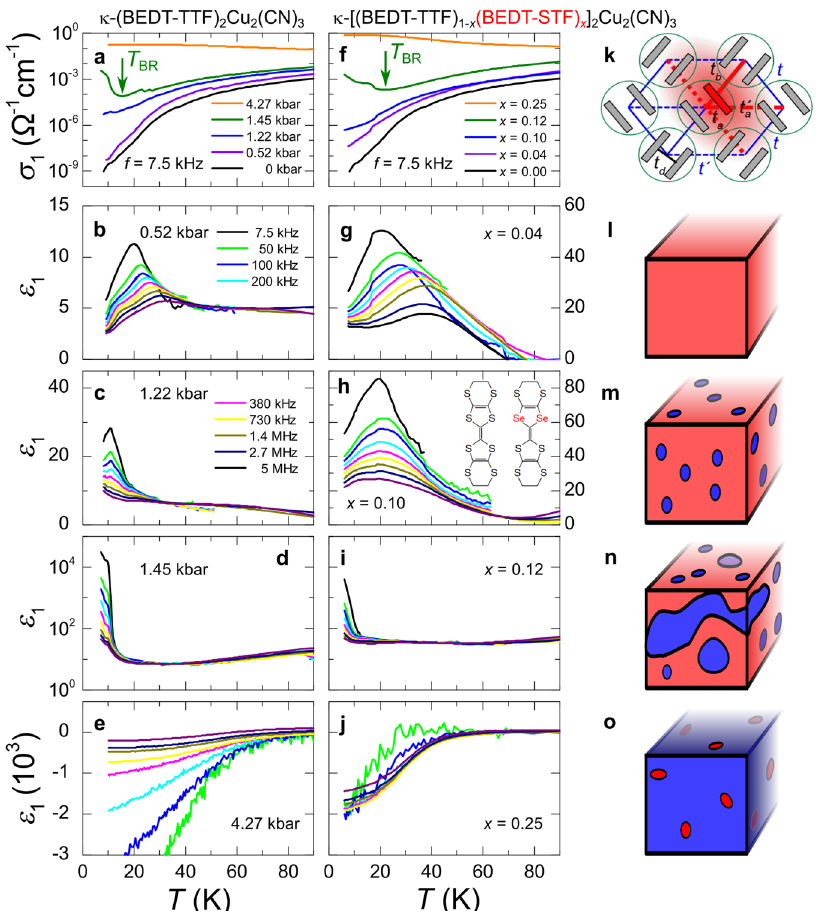
Fig. 2 Dielectric properties upon tuning through the Mott transition. The dielectric conductivity and permittivity of κ -(BEDT-TTF) 2 Cu 2 (CN) 3 were measured as a function of temperature and frequency for various applied a – e pressures and f – j chemical substitutions (introduction of Se-containing BEDT-STF molecules illustrated in h and k ) that drive the system across the Mott transition. a , f Starting from the insulator, σ 1 ( T ) grows with increasing p or x ; a metallic phase is stabilized below T BR , in accord with dc transport 5,14,21 . b , c , g , h In the Mott-insulating state ε 33,34 . Extrinsic high-temperature contributions are subtracted. d , i 1 ( T ) exhibits relaxor-ferroelectric behavior similar to the parent compound The strong enhancement of ε 1 ( T ) at the transition is a hallmark of a percolative IMT, as sketched in l – o . e , j When screening becomes dominant in the metal, ε 1 turns negative; σ 1 exhibits Fermi-liquid behavior below T FL